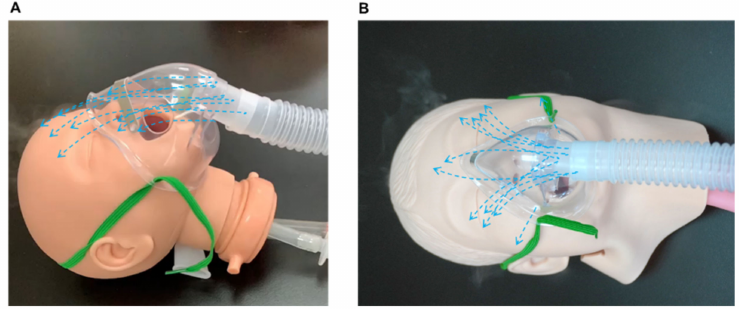
Figure 7. Oxygen delivery with a loosely fit facemask in an infant model ( A ) and tightly fit facemask in a paediatric model ( B